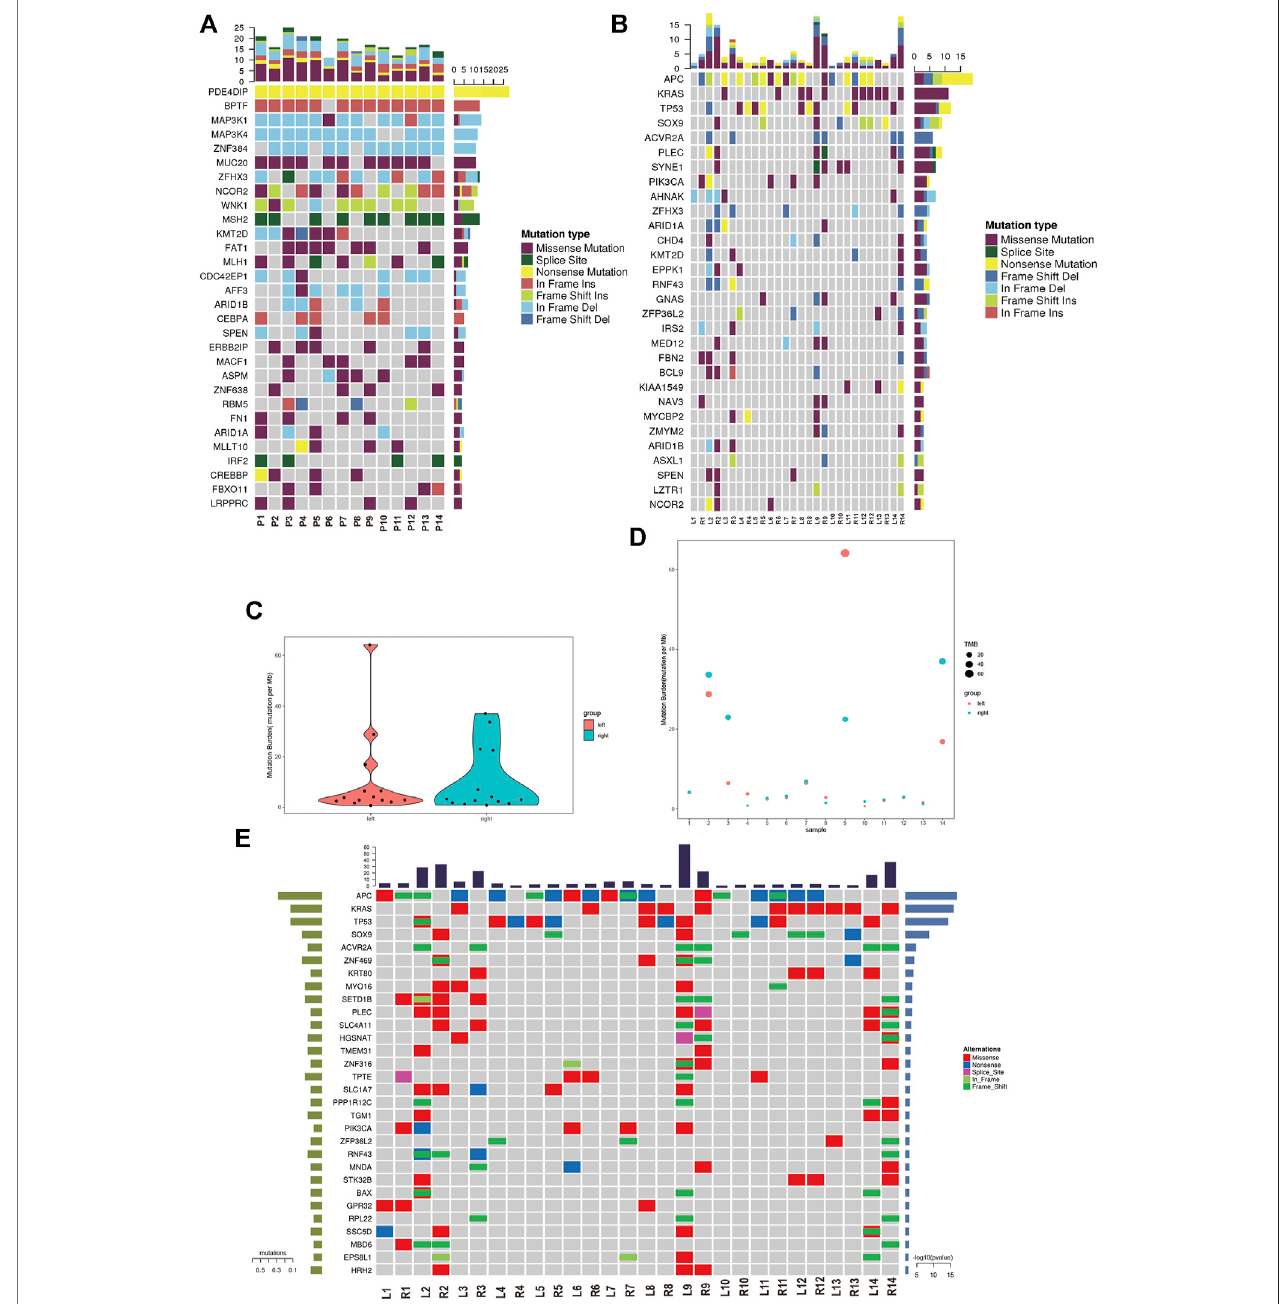
FIGURE 2 | The mutational analysis of sRL-CC. (A) The frequent predisposing genes are presented by the heatmap. The tumor mutation burden ismarked on the topoftheheatmap,thenameofpredisposinggenesismarkedontheleft,andthenumberofmutatedsamplesismarkedontheright. (B) Theoncodrivergenemutations arepresentedbytheheatmap.Thetumormutationburdenismarkedonthetopoftheheatmap,thenameofpredisposinggenesismarkedontheleft,andthenumberof mutated samples is marked on the right. (C) The tumor mutation burden is calculated in the left-sided and right-sided lesions. (D) The tumor mutation burden is calculated in both lesions of each patient. (E) The signi fi cant mutated genes are presented by the heatmap. The tumor mutation burden is marked on the top of the